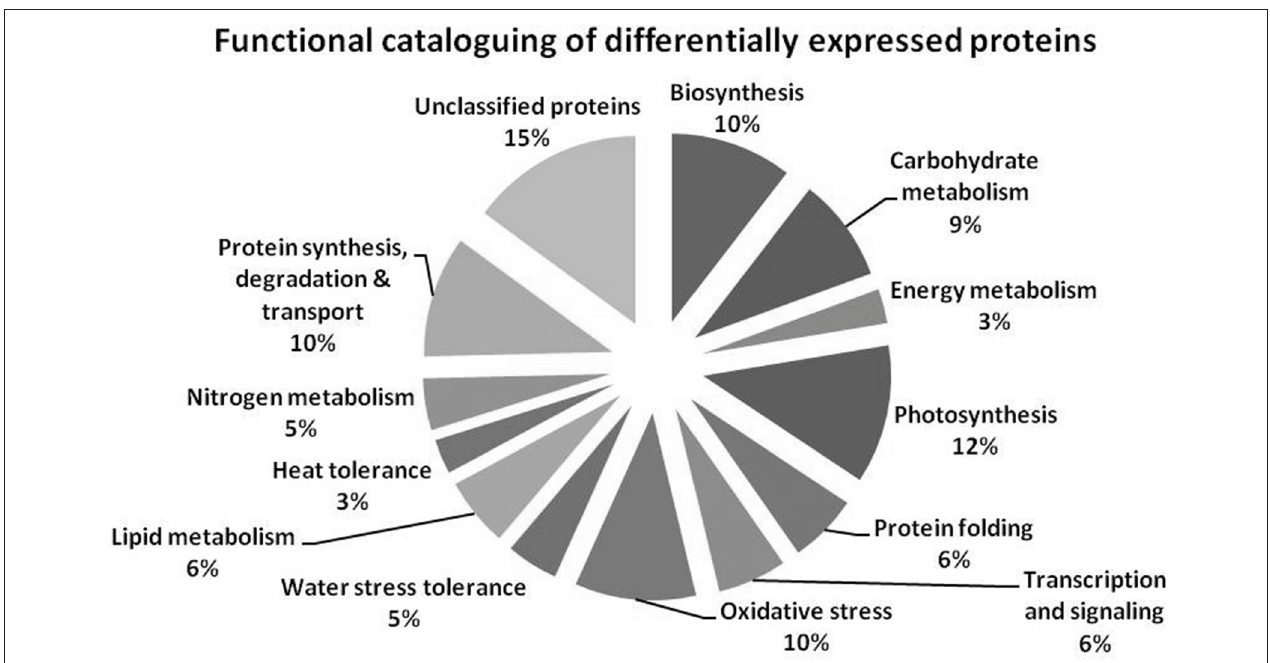
FIGURE 3 | Pie diagram showing the functional cataloguing of differentially expressed